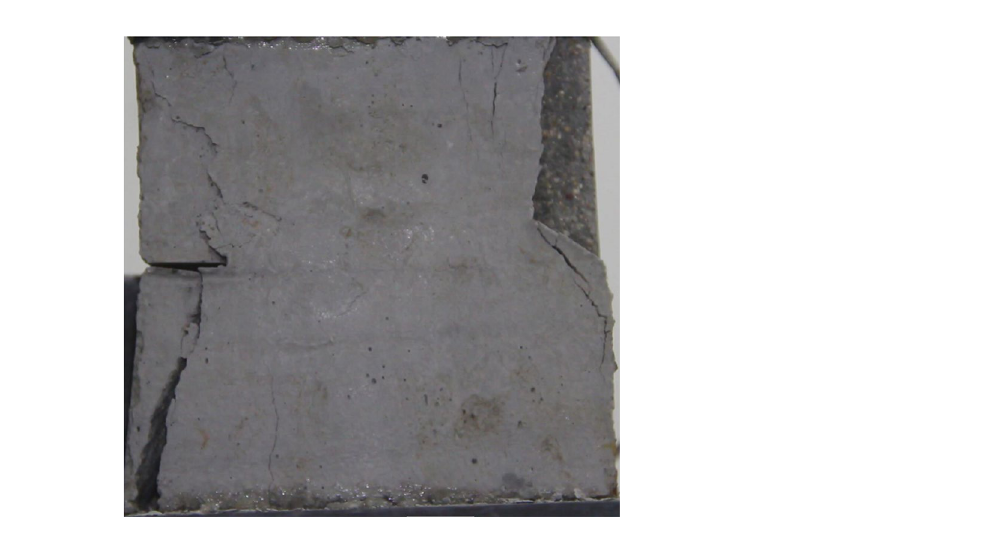
Figure 52. Photograph of a specimen showing tensile crack from the top surface caused by compression